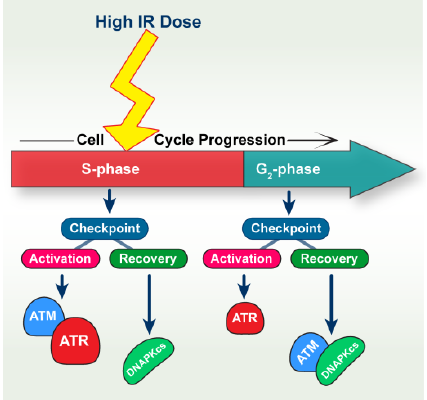
Figure 7. A model depicting the crosstalk between ATM, ATR, and DNA-PKcs in the regulation of checkpoint activation and recovery for S-phase cells exposed to high IR doses. The checkpoint is measured either in S phase (intra-S-phase checkpoint), as described in the present paper, or after progression of cells into G 2 phase, as described earlier [27]. See discussion for further details.